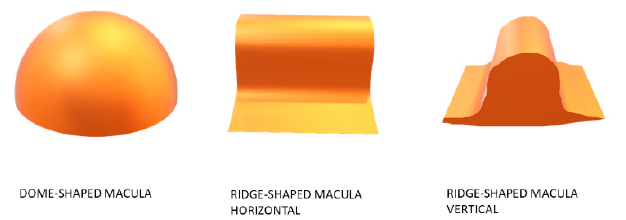
Figure 1. Geometric concepts of dome and ridge.